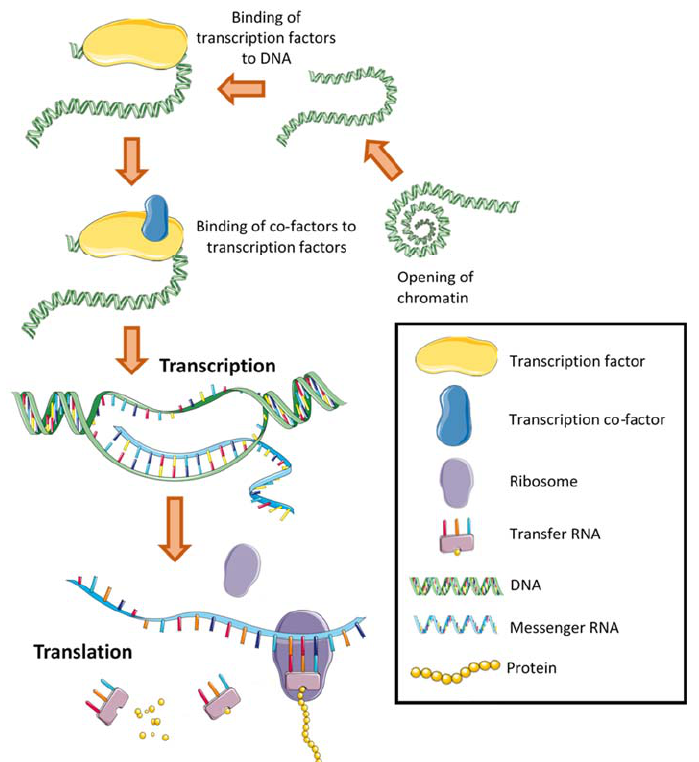
Figure 2. The regulation of gene transcription occurs through either several or all these processes. Each process may negatively or positively regulate the expression of a specific gene, influencing the resultant translation of messenger RNA into a protein. Histones and parts of the transcriptional machinery have not been shown for simplicity. Changes in transcription factor abundance in different cellular compartments, such as the nucleus and mitochondria, are initiated by various signalling networks that detect homeostatic perturbations [17]. These changes are rapid and can be triggered in skeletal muscle by a single session of exercise [18,19]. While many studies have investigated the effects of exercise on gene expression in skeletal muscle, changes in the abundance of tran ‐ scription factors in different cellular compartments that dictate these increases have re ‐ ceived limited attention [20]. This review aims to summarise the current knowledge and provide a critical analysis of the exercise ‐ induced movement of transcription factors in ‐ volved in mitochondrial biogenesis in human skeletal muscle. 3. Regulation of Transcription Factor Abundance throughout the Cell 3.1. Movement across Intracellular Membranes To control gene expression, transcription factors and their associated regulators can move into subcellular compartments through different mechanisms depending on the size, type, and charge of the molecule (Figure 3). Many proteins, including transcription factors, require co ‐ factors to bind for their function [21,22]. These co ‐ factors are typically smaller molecules, such as calcium ions, lipids, and various metabolites, which are often capable of passive diffusion through phospholipid membranes [23,24]. However, they may also be actively transported using ion channels and transporters [24,25]. For the bulk